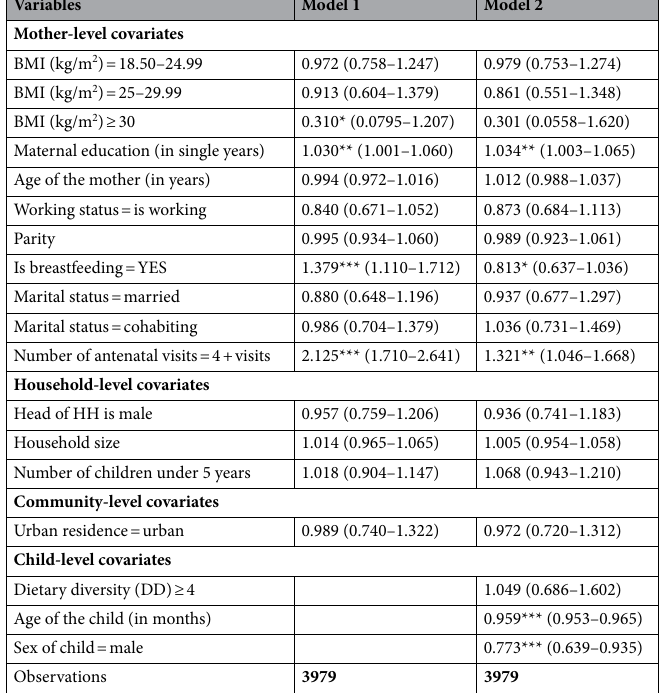
Table 2. Multivariable analysis of the effects of socio-demographic factors on better linear growth/non- stunting among children living in poor households in DRC. Significant values are in bold. 95% confidence intervals (CIs) in parentheses. DD dietary diversity, HH household, BMI Body mass index. *** p < 0.01, ** p < 0.05, * p <